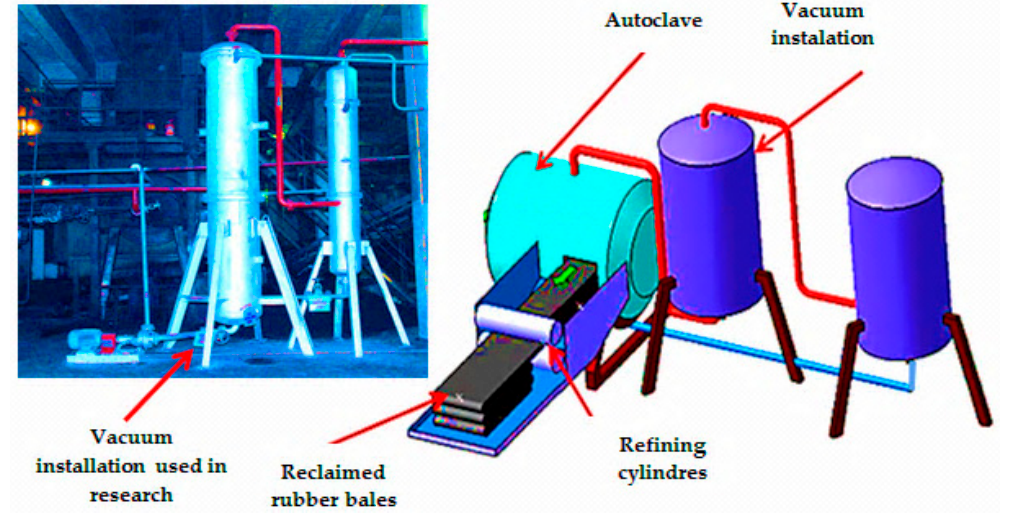
Figure 3. Vacuum system for autoclave.